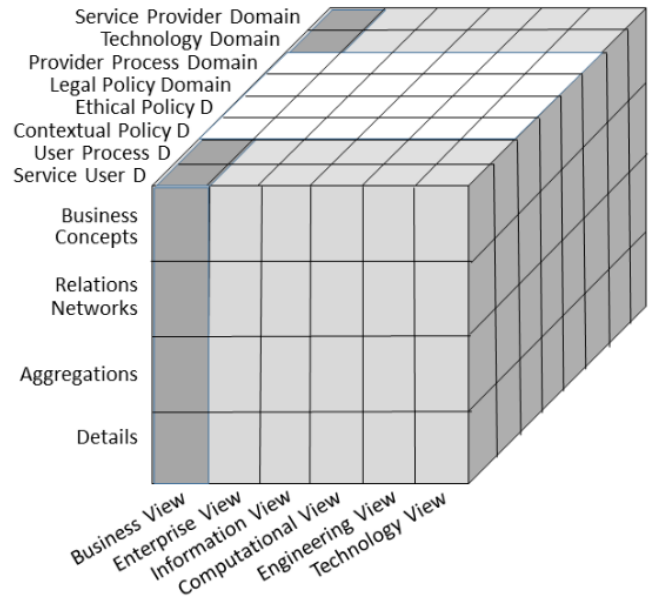
Figure 1. Representation of an ethically acceptable, privacy preserving and trustworthy Digital Health Ecosystems accredited by ISO 23,903 (after [77]).